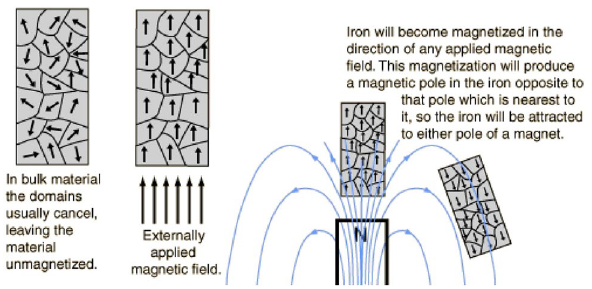
Fig. 1 Effect of magnetic field on magnetic material (Phillips and Aklestad